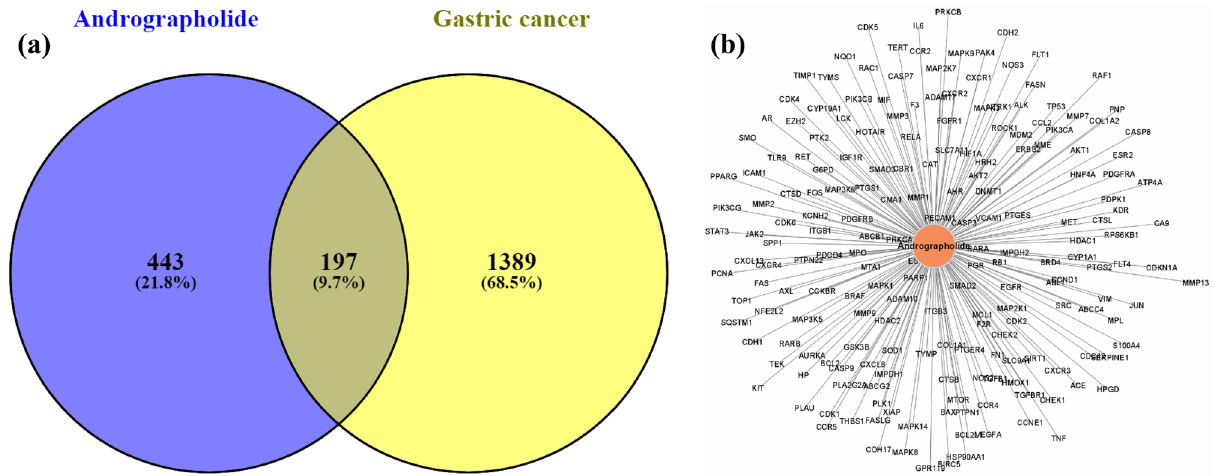
Figure 2. Common-target network. ( a ) Venn diagram of the intersection relationship of target genes between Andrographolide and GC. ( b ) Compound-Target Network generated using Cytoscape (https:// cytos cape. org/; ver.